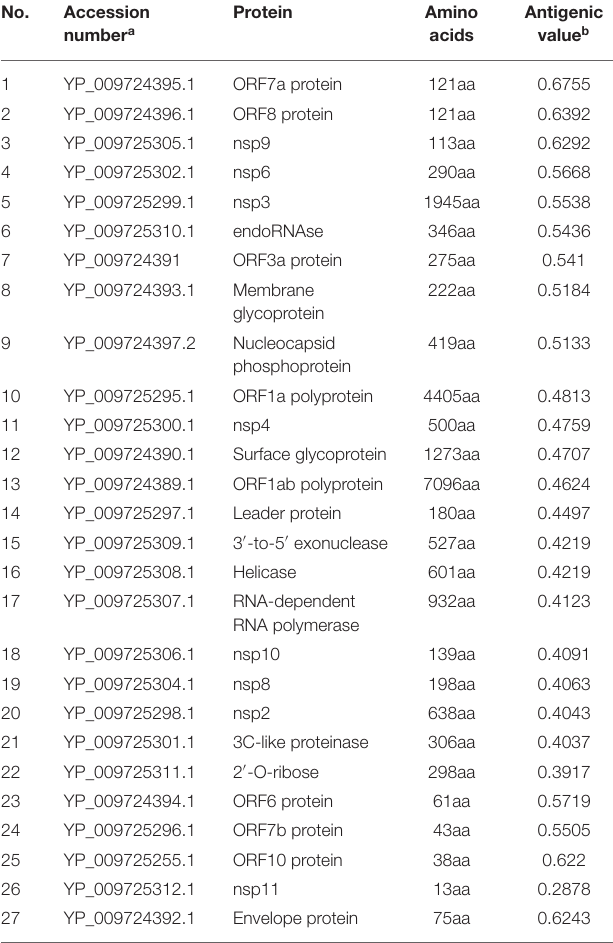
TABLE 1 | Details and antigenicity of SARS-CoV-2